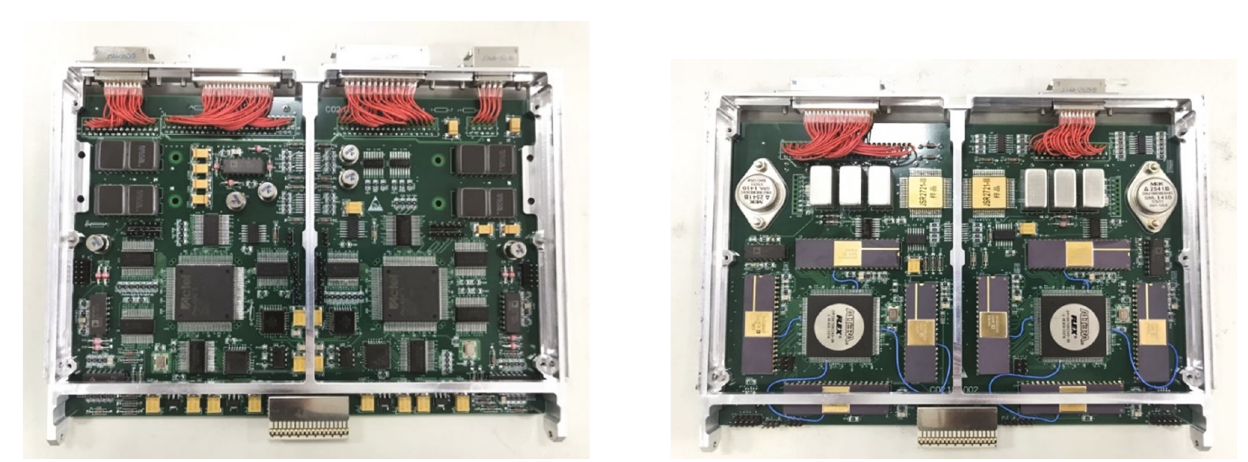
Figure 12: Stepping motor drive board. Figure 13: Resolver angle acquisition